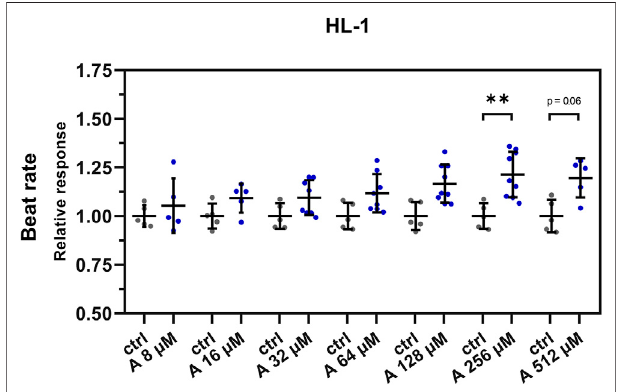
FIGURE 4 | Effect of aminophylline (A) on the BR of HL-1 cells. Scatterplots (mean ± standard deviation) of the BR (blue) normalized to a baselinemeasurement(relativeresponse)andtocontrolmeasurementmeans ( n (cid:2) 5 for A 8 and 16 µM, n (cid:2) 8 for 32 and 64 µM, n (cid:2) 9 for 128 and 256 µM, n (cid:2) 5for512 µMand n (cid:2) 5forctrl).Atleastthreebiologicalrepetitions were used in each column. Results showed linear increase of BR correlating with a higher concentration of aminophylline, with statistically signi fi cant and partially signi fi cant changes ofBR 256 and 512 µM measurementscompared thatofthecontrol(A256vs.ctlr p < 0.01,A526vs.ctlr p (cid:2) 0.06,ordinaryone- way